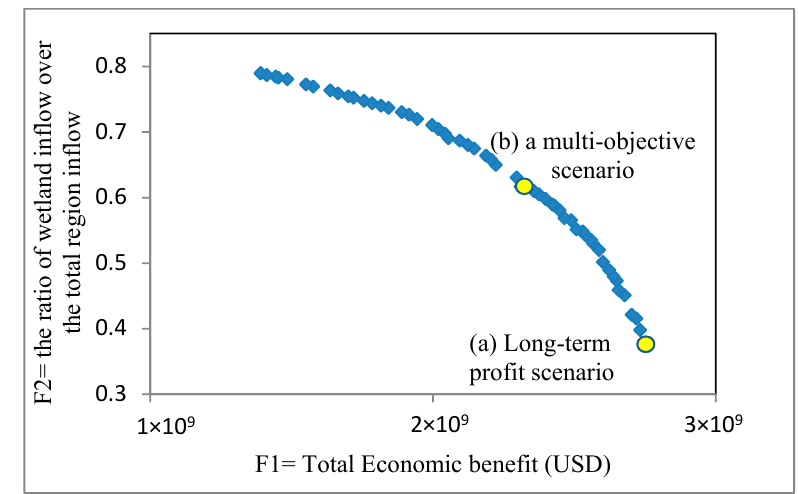
Figure 7. Pareto front of a multi-objective optimization run for the two-objective functions. The blue squares comprise the Pareto-optimal data set, i.e., the Pareto front. The yellow circles